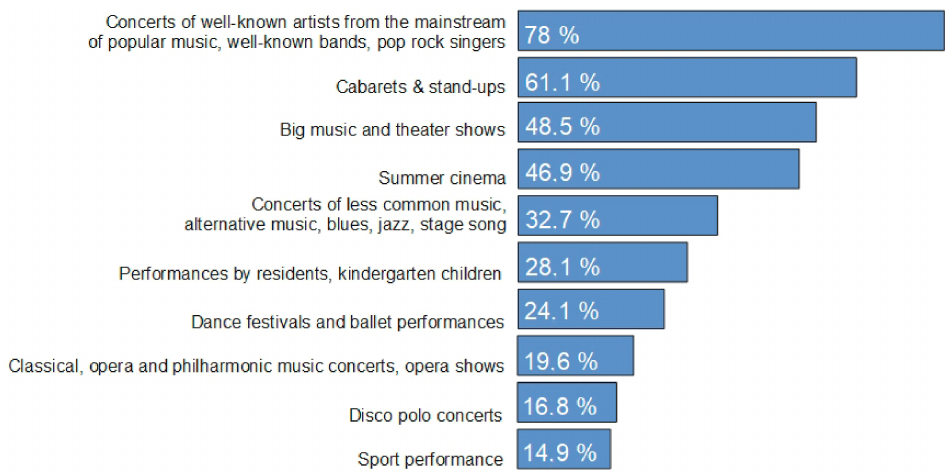
Figure 9. Survey on the expected functions of the new Odeon in Koszalin. Original chart based on